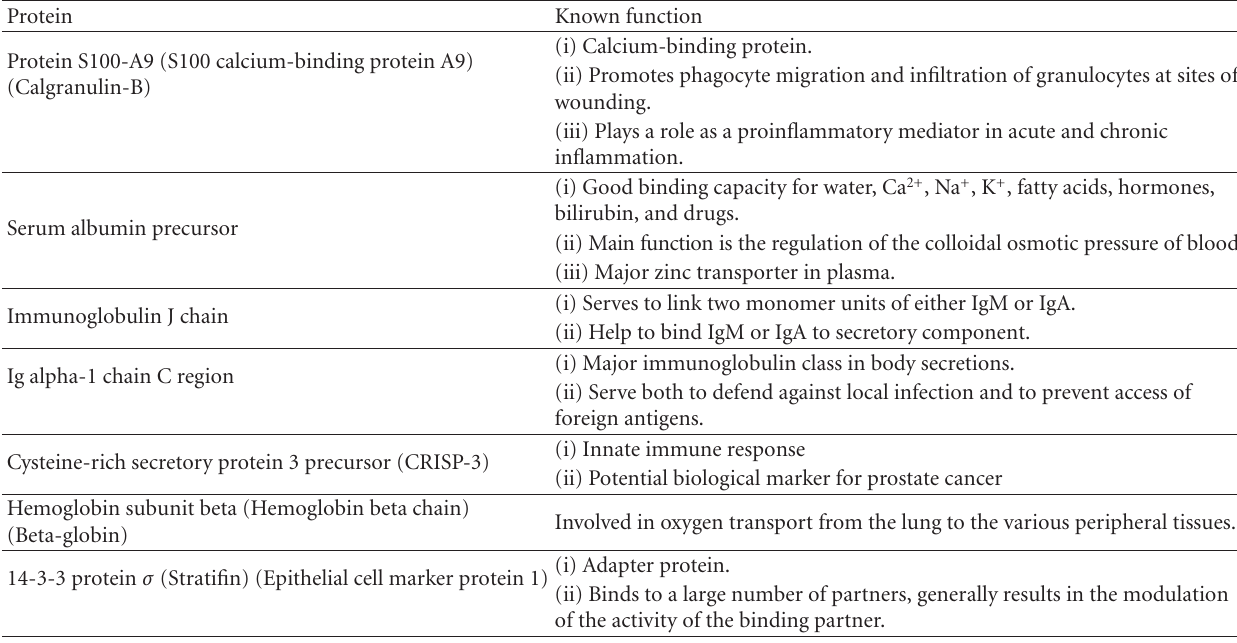
Table 2: Summary of identified proteins and their known functions. Known